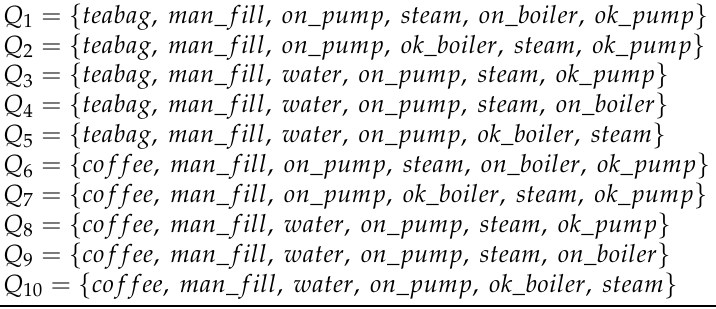
Figure 2. All the w.b. of the KB for expresso machine.